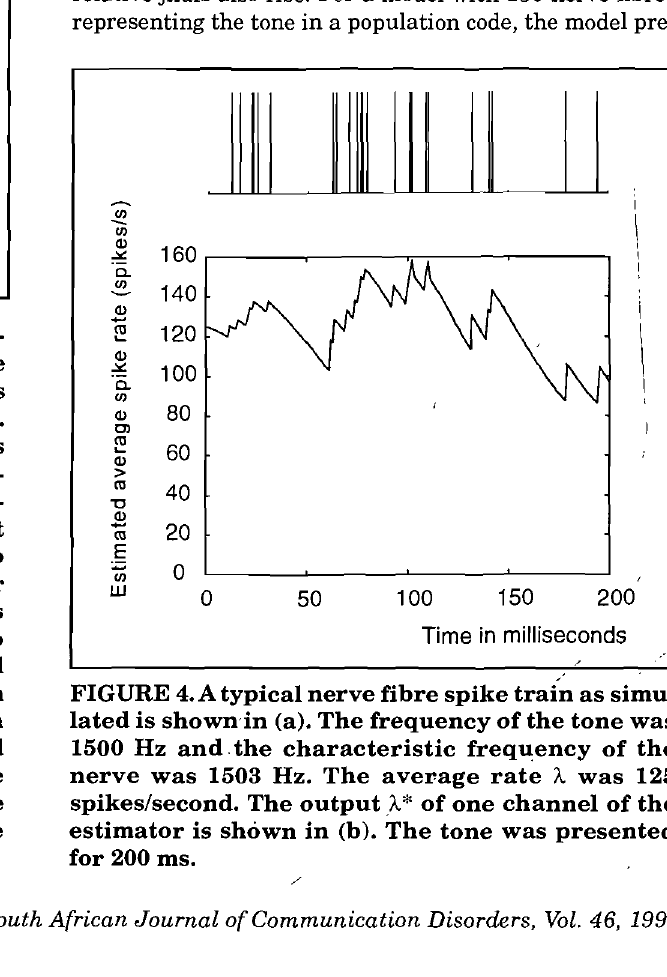
FIGURE 4.A typical nerve fibre spike train as simu lated is shown in (a). The frequency of the tone was 1500 Hz and. the characteristic frequency of the nerve was 1503 Hz. The average rate t.. was 125 spikes/second. The output ,t.. * of one channel of the estimator is shown in (b). The tone was presented for 200